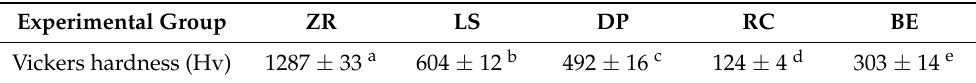
Table 2. Mean ± standard deviation of Vickers hardness of the specimens. Experimental Group